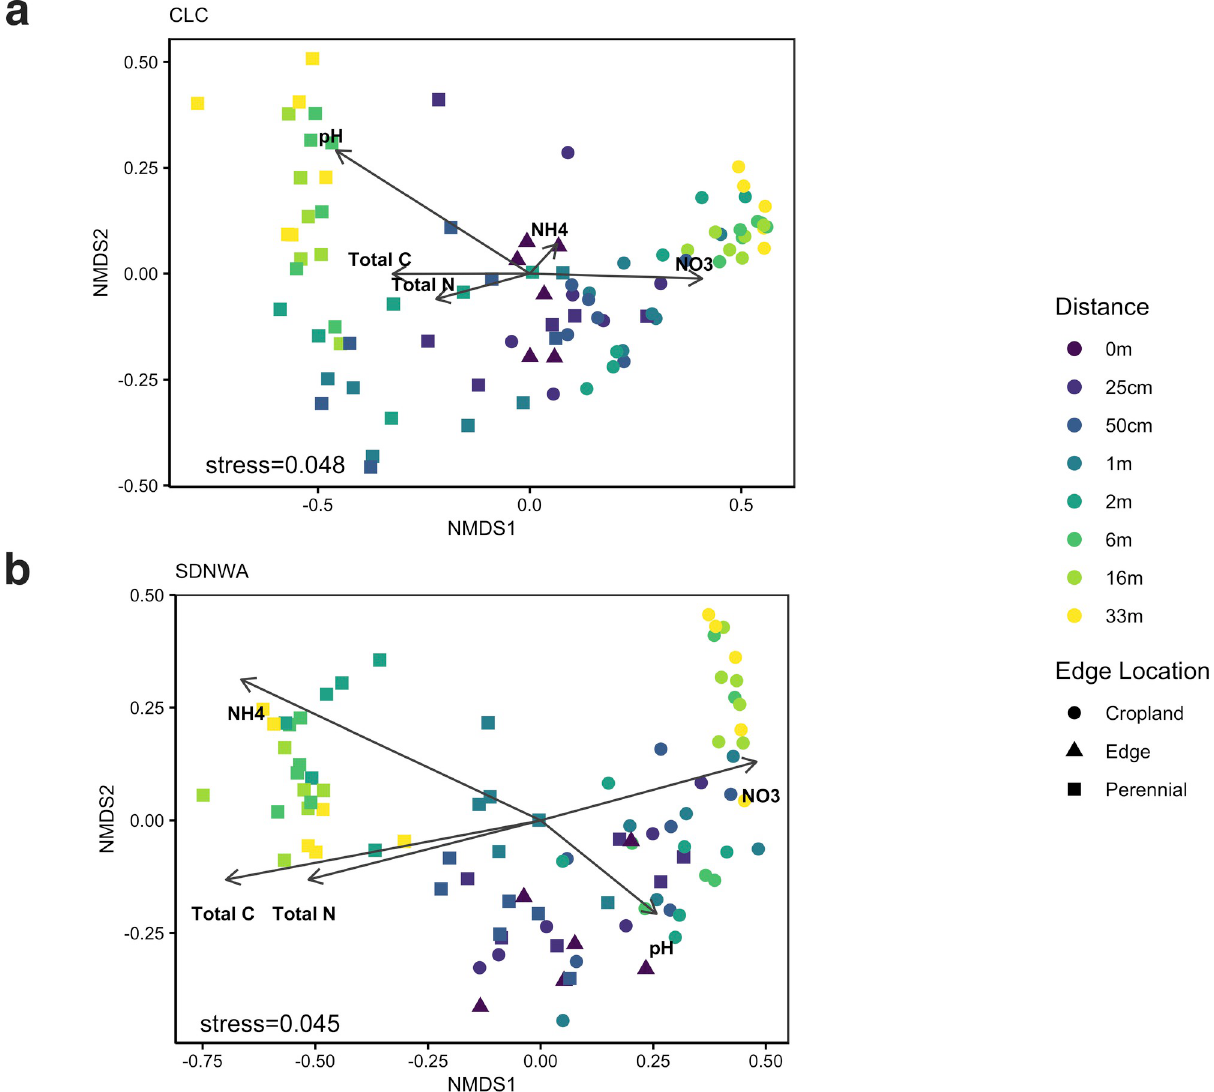
Fig 2. Non-metric multidimensional scaling analysis of vegetation cover. A non-metric multidimensional scaling analysis of vegetation cover at (a) Conservation Learning Centre and (b) St. Denis National Wildlife Area. The colour gradient represents sampling points from 0 m to 33m (into either cropland or perennial grassland), with 0 m being the edge. Shapes represent edge location, triangles are edge points (0m), squares represent points in the perennial grassland and circles represent points in the cropland. Soil property vectors are overlaid on each plot.